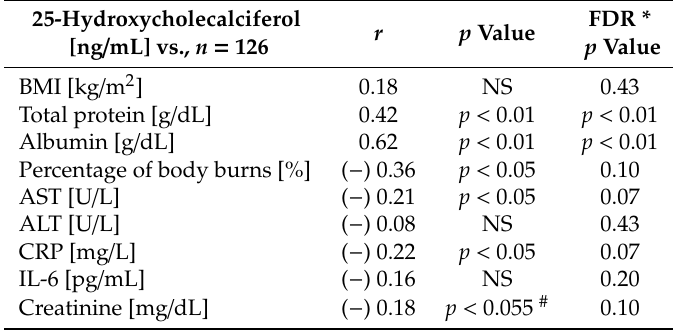
Table 4. Correlation between 25-hydroxycholecalciferol concentration and biochemical parameters.